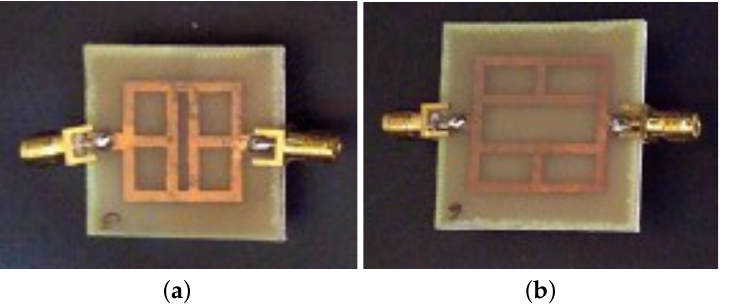
Figure 17. Photos of the prototypes with T-shaped stubs: ( a ) T-stubs length equal to L perpendicular and ( b ) parallel to the microstrip feeding